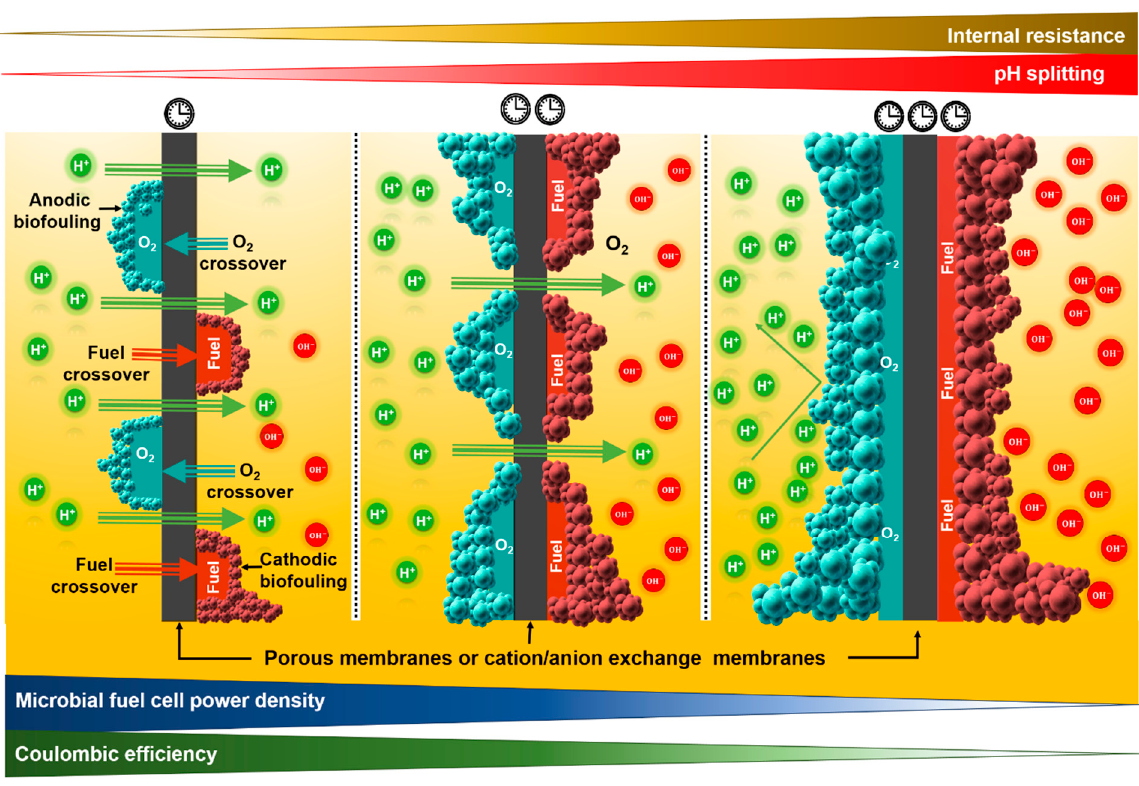
Figure 4. Membrane-use disadvantages in microbial fuel Figure 4. Membrane ‐ use disadvantages in microbial fuel cells.